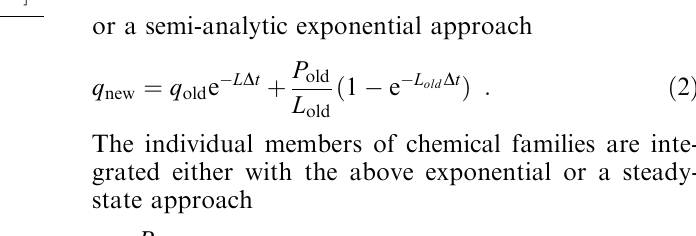
Table 3. Photolytic reactions used in the model Reaction